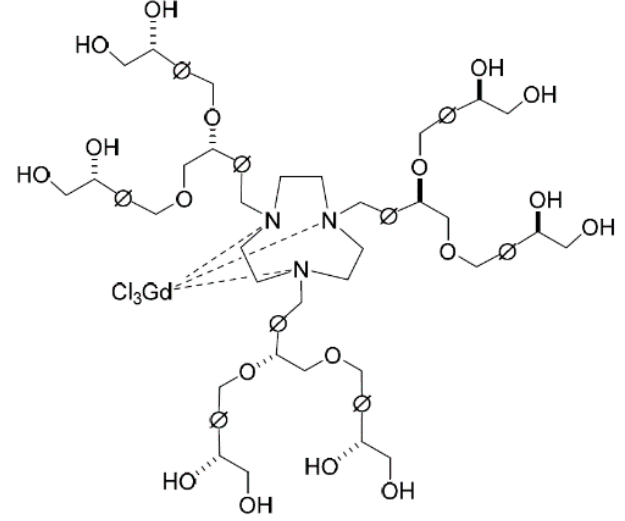
Figure 1. Structure of 2nd-generation chiral dendrimer-triamine-coordinated Gd-MRI CA with polyol end-groups, 2 -( R ).